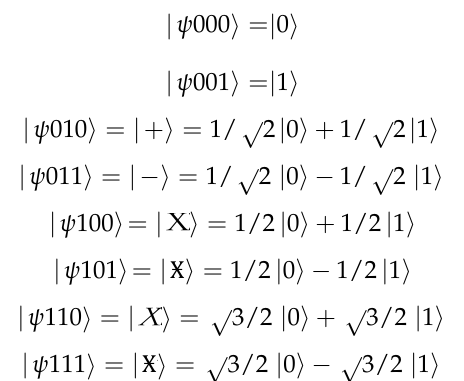
Figure 1. The corresponding base representations for the octal states of qubits are given as ‘ ┼ ’, ’ X’, ’±’, and ’ Ӿ ’.